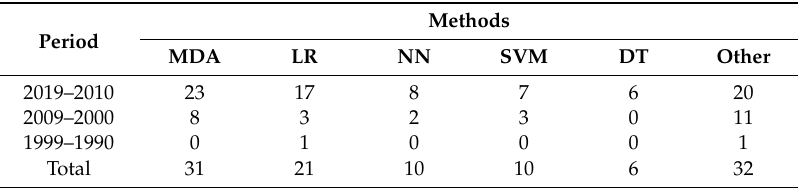
Table 1. The list of methods used in the selected